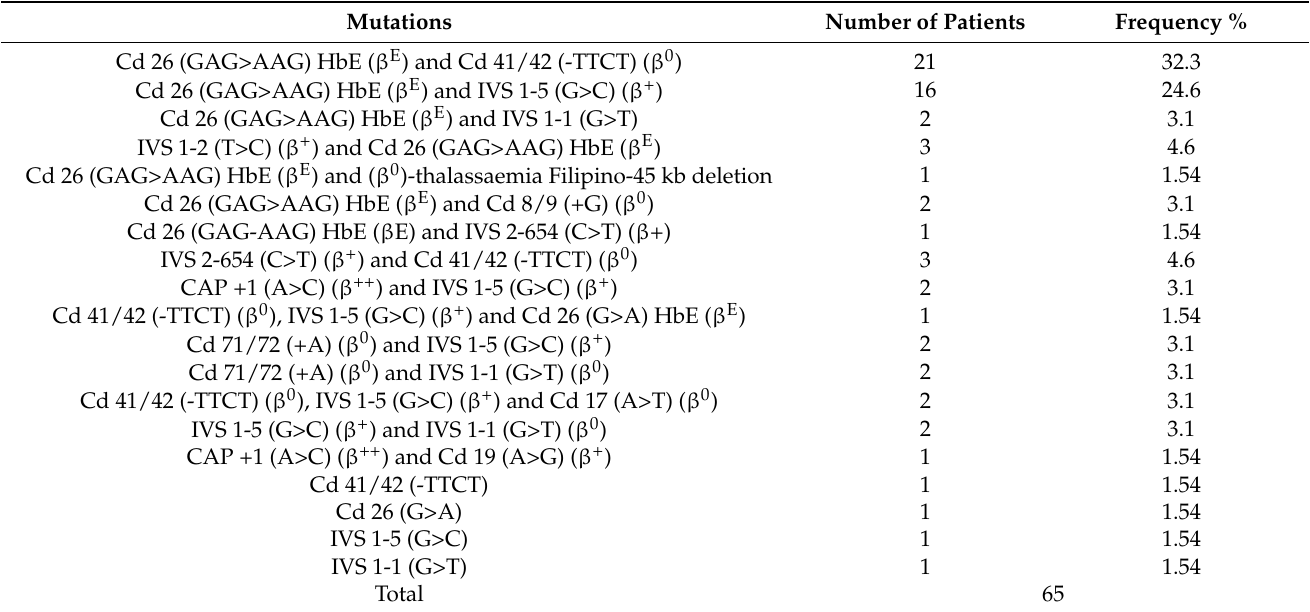
Table 4. Types of compounds and heterozygous and homozygous mutations in HbE/ β -thalassaemia patients.